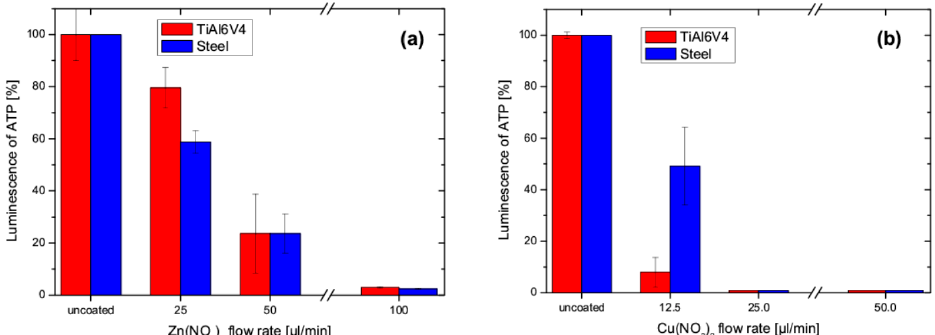
Figure 10. Influence of the flow rate used for ( a ) Zn-SiO x films grown with a secondary precursor concentration of 5 wt.% Zn(NO 3 ) 2 and ( b ) Cu-SiO x films grown with a secondary precursor concentration of 2.5 wt.% Cu(NO 3 ) 2 on detectable luminescence of ATP after 1000 washing cycles. Uncoated austenitic stainless steel and TiAl6V4 samples are included as references.